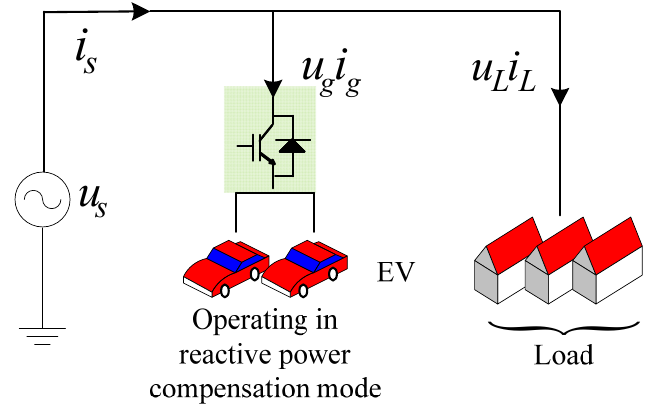
Figure 5. Simplified model of the household single-phase power supply